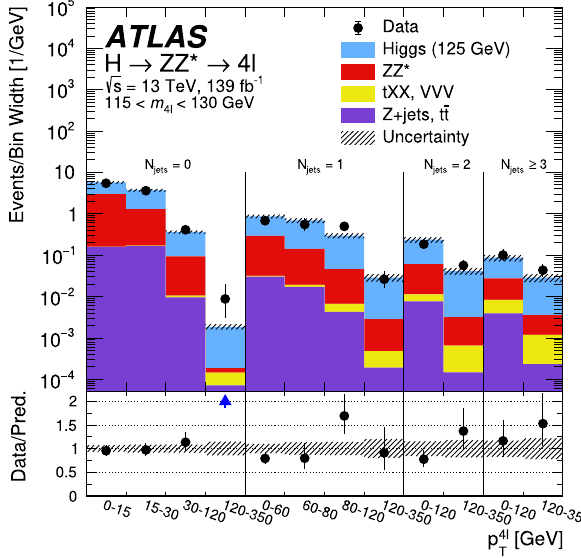
Fig. 11 The observed and expected (pre-fit) distributions of p 4 (cid:3) in T | y | bins in the mass region 115 < m 4 (cid:3) √ luminosity of 139 fb − 1 collected at s = 13 TeV. A SM Higgs boson signal with a mass m H = 125 GeV is assumed. The uncertainty in the prediction is shown by the hatched band, which includes the theoret- ical uncertainties of the SM cross section for the signal and the Z Z ∗